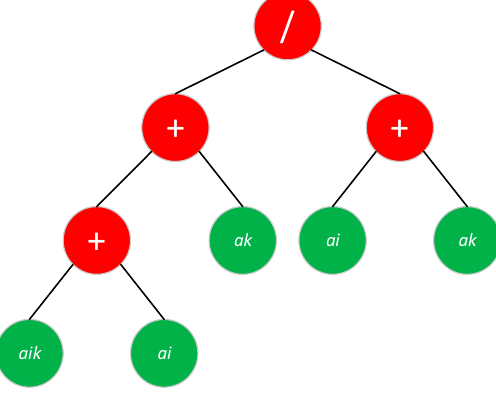
Figure 2. Example of solution tree for Jaccard dissimilarity metric.